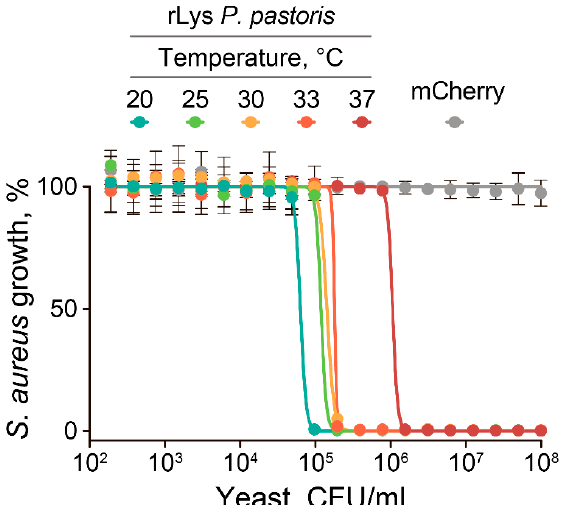
Figure 3. Growth temperature influences the inhibitory activity of the live rLys P. pastoris cell culture.